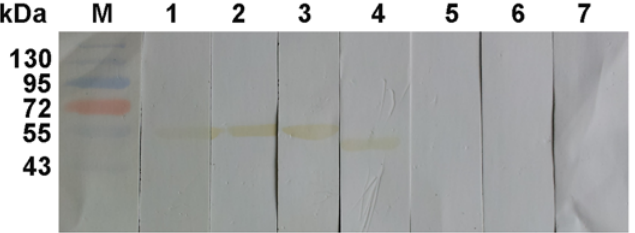
Fig 3. Western blotting analysis of r Cs HK. Pre-stained protein markers (lane M), r Cs HK reacted with serum from C . sinensis infected humans (lane 1), serum from C . sinensis infected rats (lane 2), or rat anti- Cs ESPs serum (lane 3). Cs ESPs were probed with anti-r Cs HK rat serum (lane 4). r Cs HK did not react with serum from healthy people (lane 5) nor with serum from pre-immune rats (lane 6), and Cs ESPs probed with serum from pre-immune rats (lane